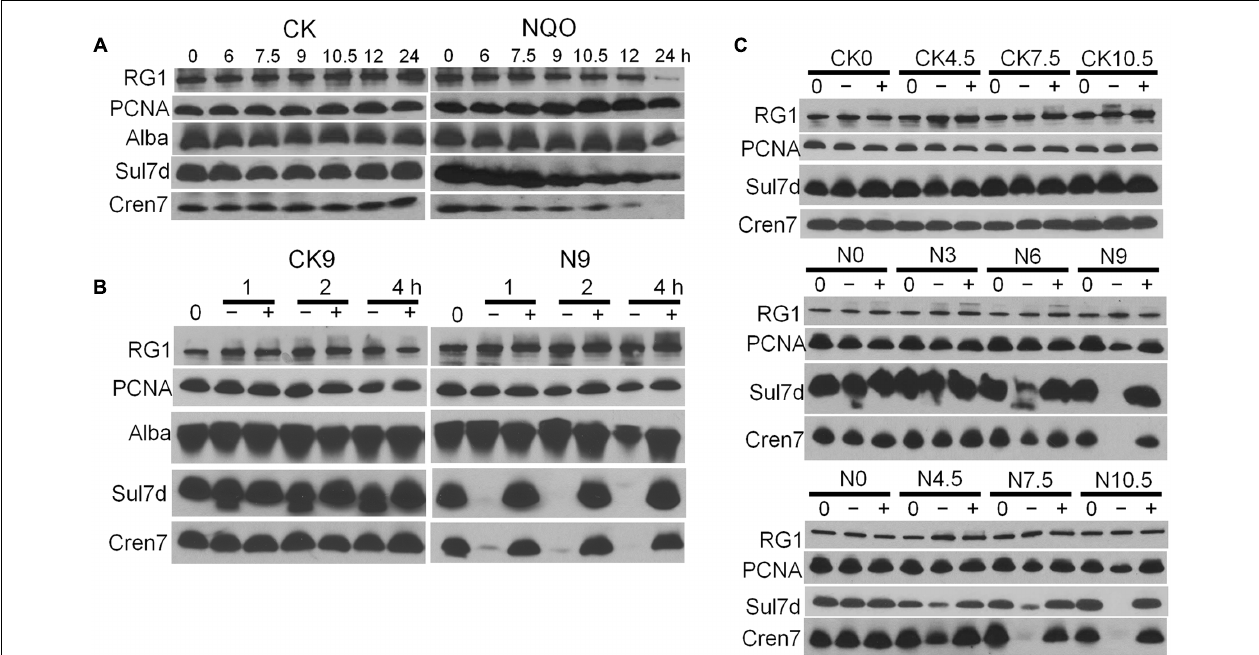
FIGURE 3 | 4-Nitroquinoline 1-oxide treatment activates a metalloprotease that specifically degrades Cren7 and Sul7. (A) The samples were taken at indicated time points from untreated or NQO-treated cultures and analyzed by western blot using corresponding antisera. (B) Cell extracts were prepared from untreated cells (CK) and the cells treated with NQO for 9 h (N9). The cell extracts were then incubated at 75 ◦ C with (+) or without EDTA (–) for 1, 2, and 4 h. “0” represents original cell extracts without incubation. At last, levels of indicated proteins were analyzed by western blot. (C) Cell extracts were prepared at indicated time points from untreated or NQO-treated cultures. Then, the degradation of Sul7 and Cren7 was analyzed by the in vitro proteolytic assay as described in (B) . Here, the cell extracts were incubated at 75 ◦ C for 2 h. In (A) , total protein from about 1.3 × 10 8 cells, given that a culture of A 600 = 1.0 contains 1 × 10 9 cells per ml, was loaded onto the gel, while in (B,C) , about 20 µ g total protein was